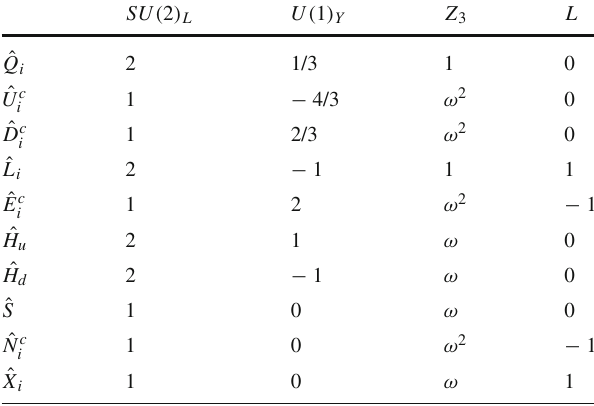
Table 1 Quantum numbers associated with the gauge symmetry group SU ( 2 ) L , U ( 1 ) Y , the Z 3 charge ( ω = e i 2 π/ 3 ) and the lepton number L for the NMSSM superfields. The generation index i runs from one to